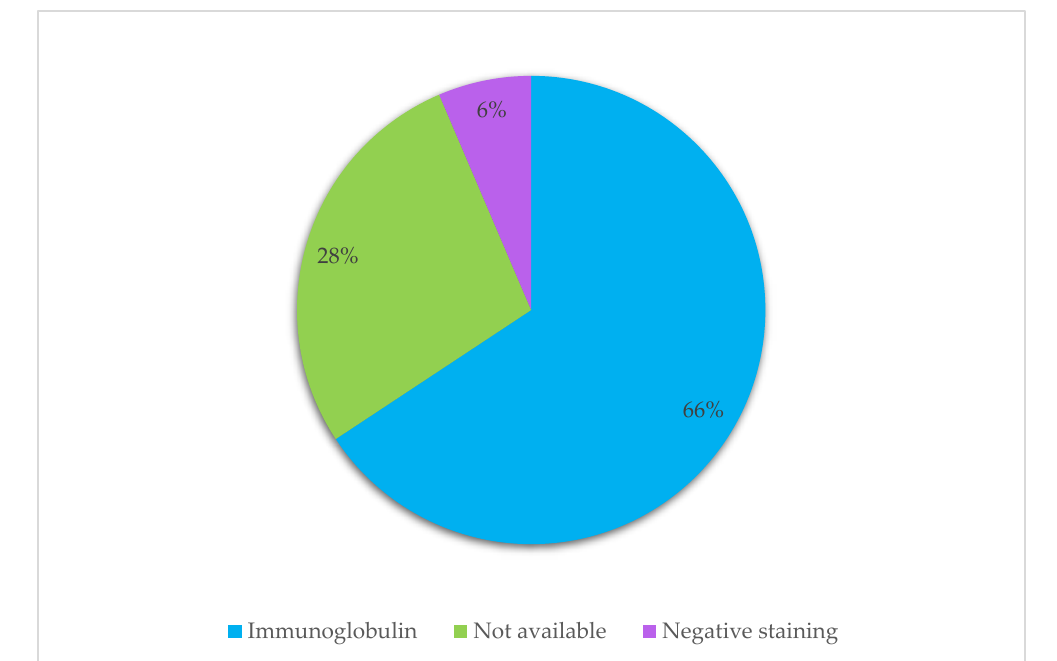
Figure 7. Distribution of the deposited material within histiocytes. The figure presents the distribution of material within histiocytes in identified cases, as described by immunohistochemical stains, to determine the origin of the deposited material. Table 4. CSH classification according to crystal and etiology.